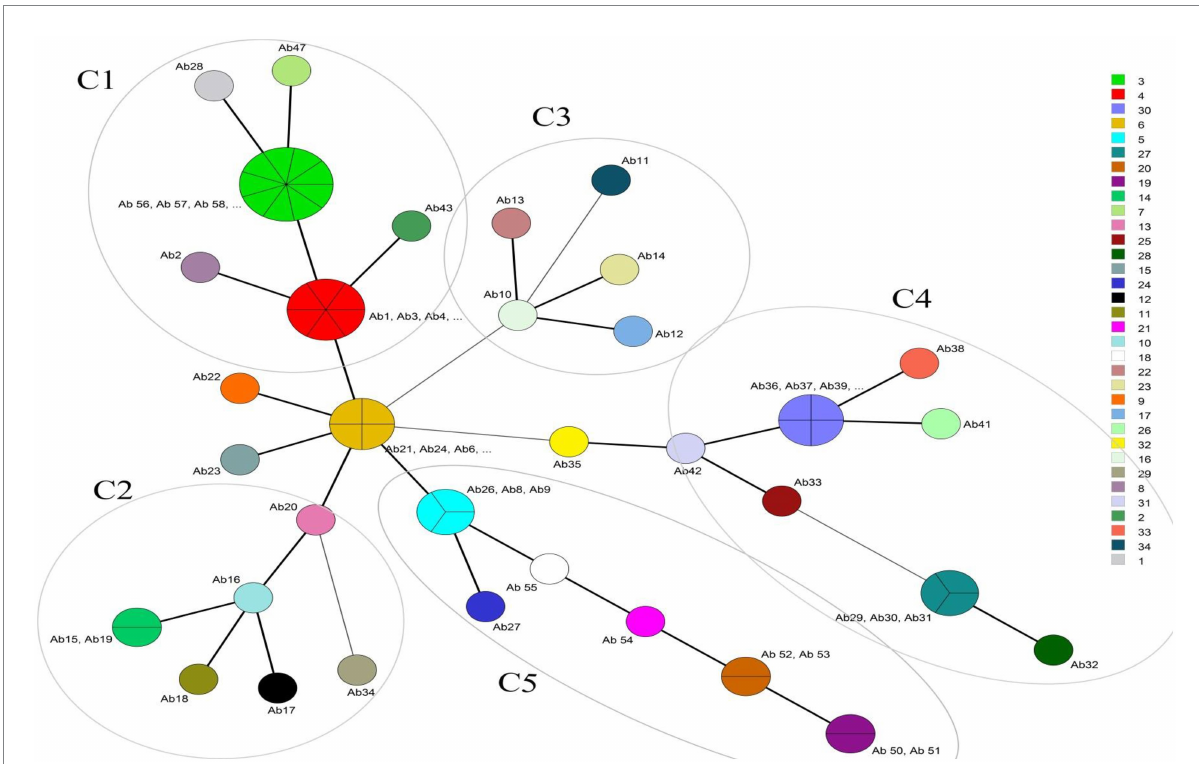
FIGURE 1 Minimum spanning tree of 60 A. baumannii isolates detected for MLVA types (MTs). The right column shows different MTs. Each circle represents isolate number (Ab). The size of each circle indicates the number of isolates within these MTs. Strains that fall into the same MT type are shown with the same color. For example Ab1, Ab3, Ab4, Ab5, Ab44, and Ab45 are located in MT4 because they have the same VNTR numbers (6 7 5 5 9 12 8 12). The different clusters (C1-C5) are annotated. The most isolates were in cluster 1(C1, n = 19) and cluster 4 (C4, n = 12), respectively. The highest diversity of MTs is in cluster 4. Thick and short lines connecting two types denote types differing in a single locus; thin, longer lines connect double-locus variants; and dashed lines indicate the most likely connection between two types differing in more than two